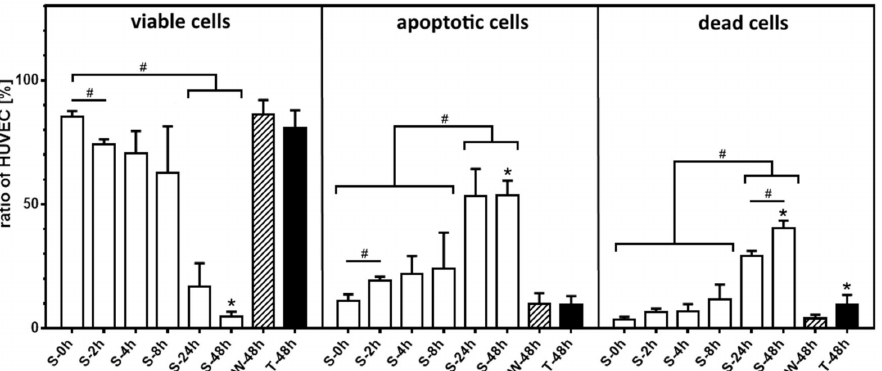
Figure 4. Decrease of HUVEC viability and high fraction of apoptotic/dead cells at nonadher- ent conditions over time. Time-depended distribution of nonadherent HUVEC viability status (viable = Annexin-V and DAPI negative, apoptotic = Annexin-V positive and DAPI negative, dead = Annexin-V and DAPI positive) compared to TCP grown control (W-48h) and with sup- plementation of rhTNF- α (T-48h) as positive control for artificial apoptosis induction. Data shown as arithmetic mean ± standard deviation; * p compared to growth control on TCP (W-48h); # p compared in between samples of nonadherent HUVEC; n = 6 from two independent experimental series with n = 3 HUVEC seedings each.